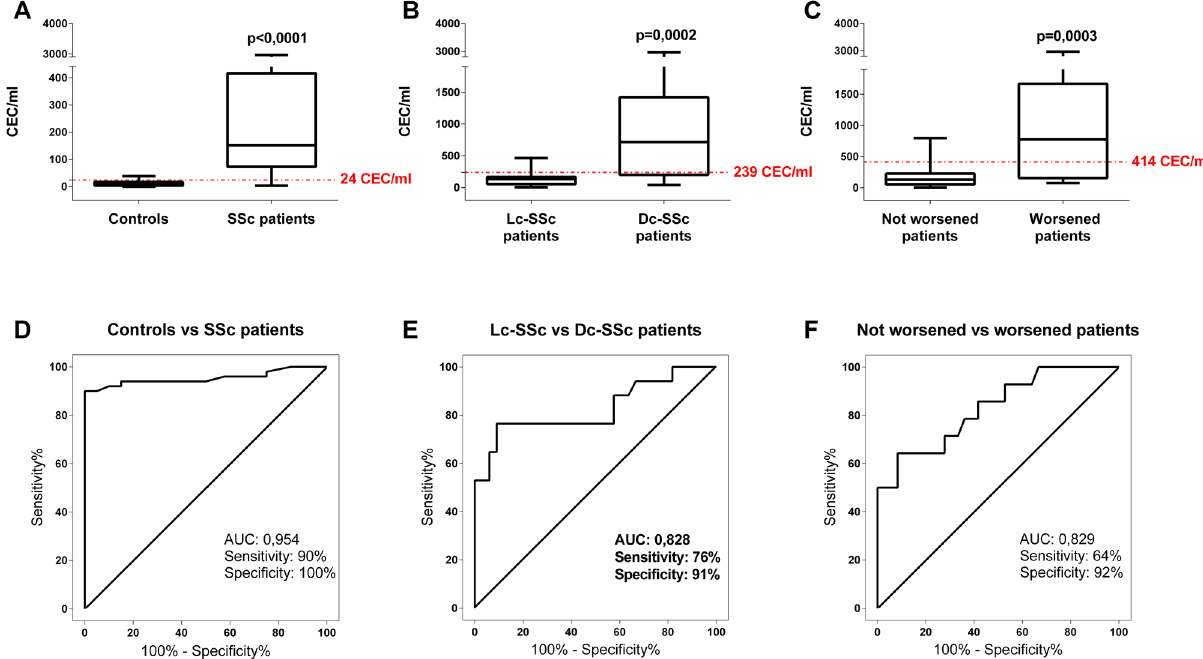
Figure 1. Circulating endothelial cells (CEC) in healthy controls and SSc patients. Boxplots show the median CEC counts and whiskers from minimum to maximum comparing healthy donors and SSC patients ( A ), limited cutaneous (lc-SSc) and diffuse cutaneous (dc-SSc) patients ( B ), not worsened versus worsened patients ( C ). Red grid line in boxplots indicates the CEC value cut-off of related ROC curve. D, E, F represent ROC-curves of the absolute CEC count distinguishing controls from SSc patients ( D ), limited cutaneous (lc-SSc) and diffuse cutaneous (dc-SSc) patients ( E ), not worsened from worsened SSc patients ( F